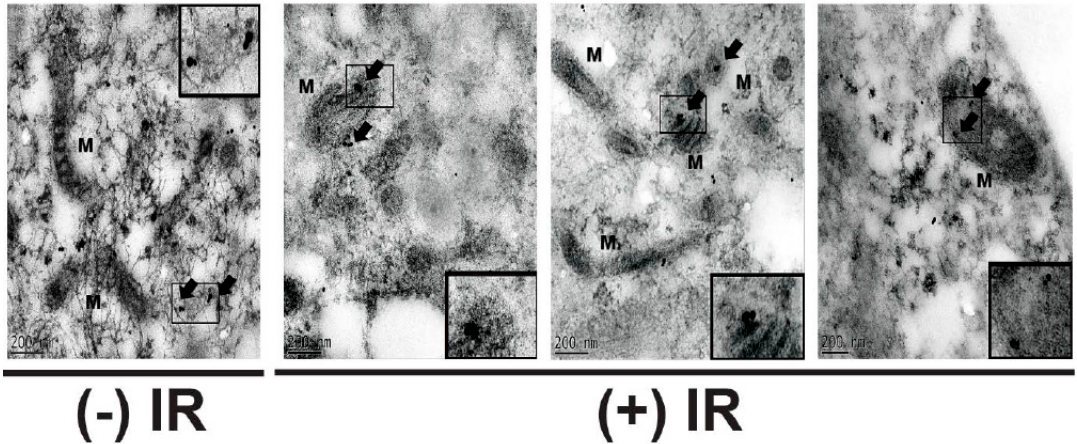
Figure 2. Immunogold staining and transmission electron microscopy demonstrating cyclin B1 mitochondria translocation. The control and 6 Gy irradiated NHFs were harvested at 4 h post-irradiation for the electron microscopy assay, following our previously published protocol (11). The box shows sections of the mitochondrion; insets represent magnified sections of the mitochondrion; arrows show cyclin B1; M: mitochondrion Results obtained from the confocal and electron microscopy assays were further verified, using cell fractionation assays. NHFs, synchronized by contact inhibition (<2% S phase, measured by flow cytometric analysis of DNA content), were re-plated at a lower density and irradiated with 6 Gy at 18 h post-plating. Control and irradiated cells were harvested and used for cell fractionation, using the cell fractionation kit from Qiagen, following the manufacturer’s supplied protocol. Antibodies,